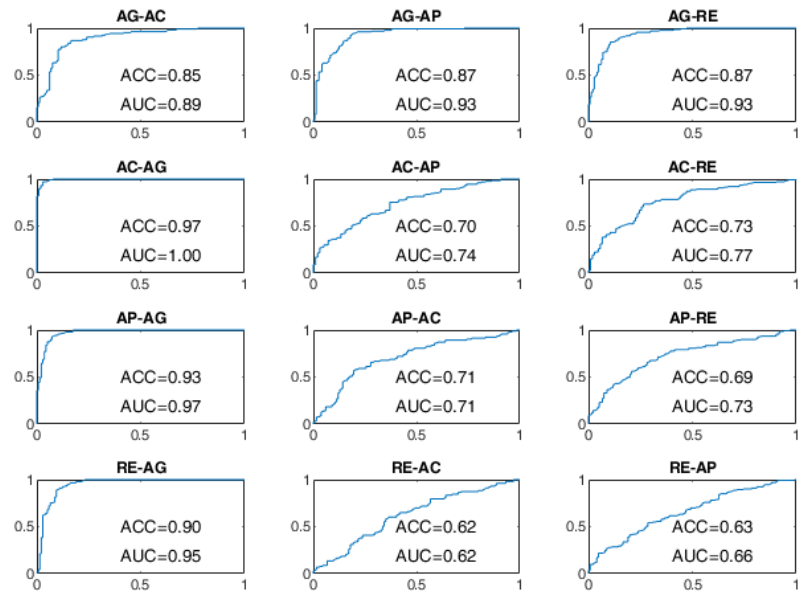
Figure 8 . ROC curves of the OCSVM approach on the DS1 dataset for WD = 15 s.